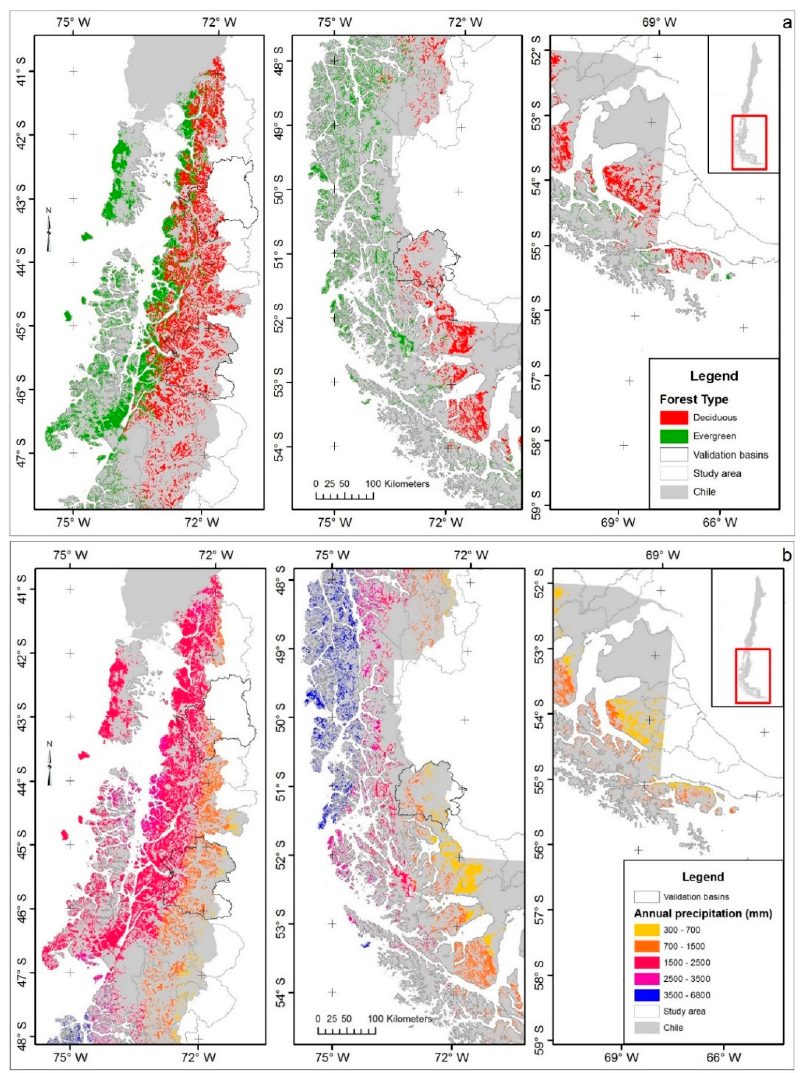
Figure 4. Regional map of potential IFWs in Chile, as a function of deciduous/evergreen phenology ( a ) and annual precipitation ( b ). Note that watersheds classified as evergreen forest type include many transitional or mixed types, often with deciduous species at higher elevations within the same watersheds (see text).